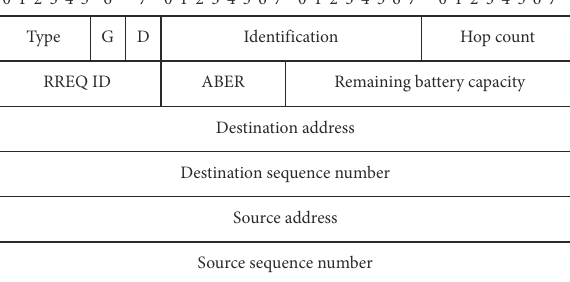
Figure 7. RREQ format of ARS